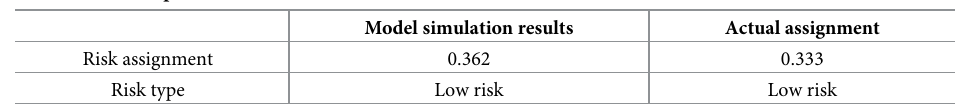
Table 3. Test sample